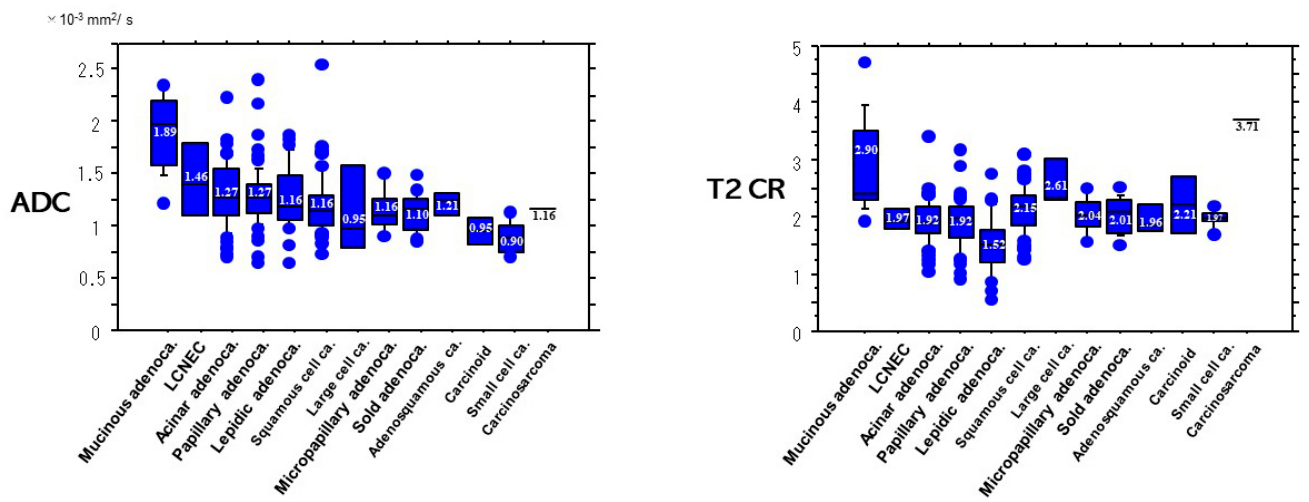
Figure 8. ADC and T2 CR based on pathologic subtypes of lung cancer. Both the ADC and the T2CR of mucinous adenocarcinoma were significantly higher than those of other pathologic subtypes.